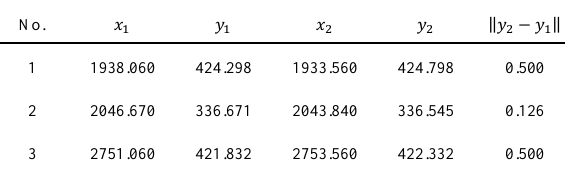
Figure 5. Computed Epipolar